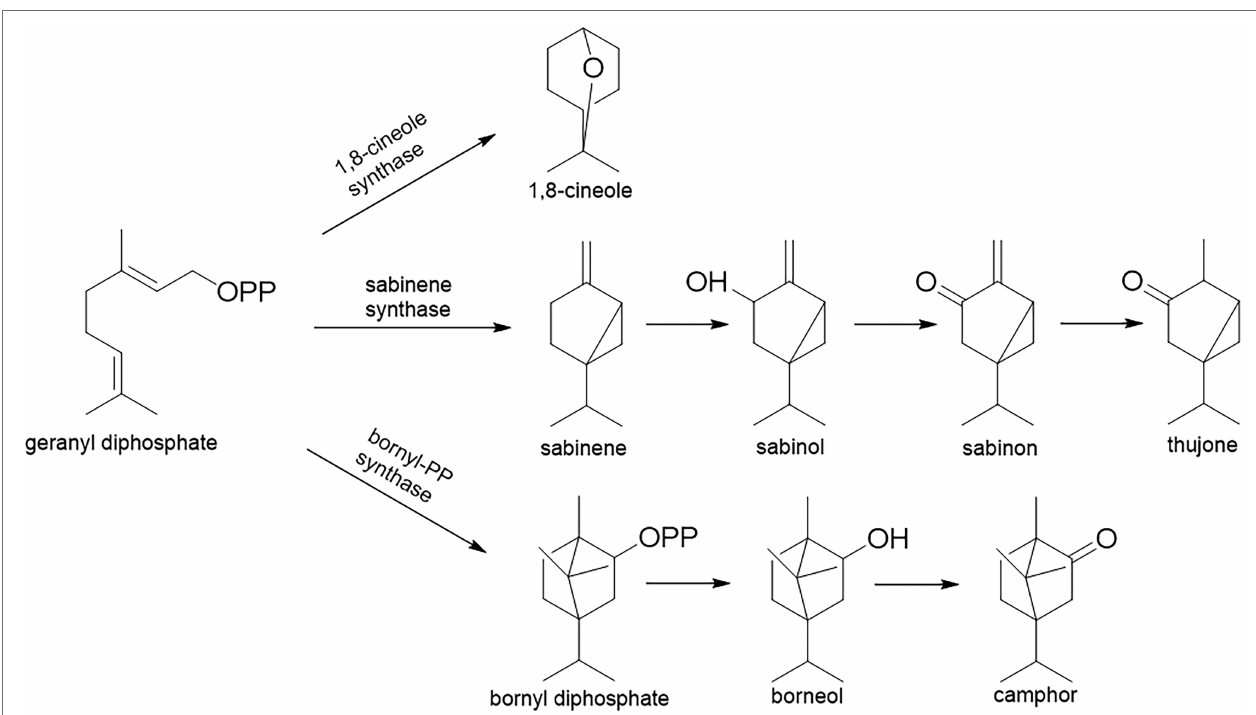
FIGURE 2 | Monoterpene biosynthetic pathways in Salvia glandular